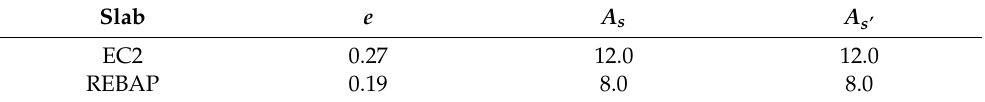
Table 12. Slab dimension for third case of study ( e , As , As’ values in m and cm 2 /m).